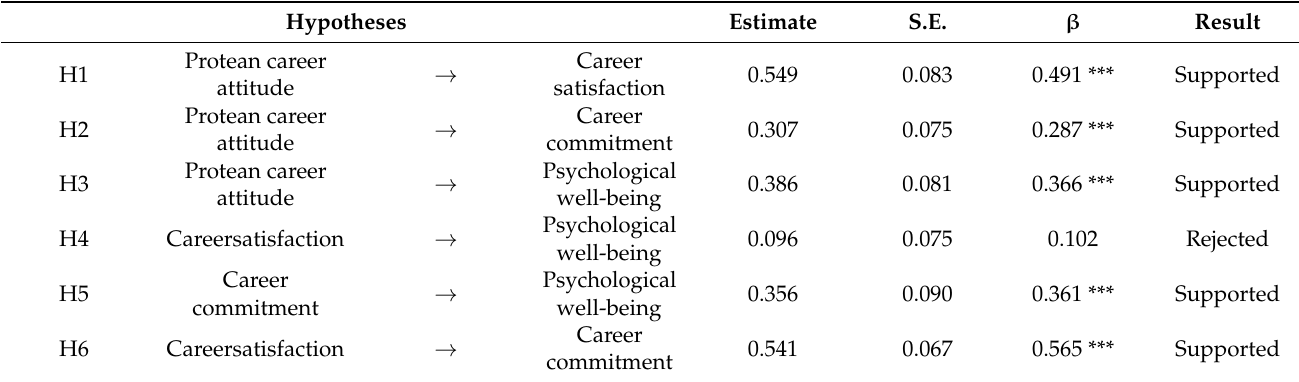
Table 4. Results of SEM (Structural Equation